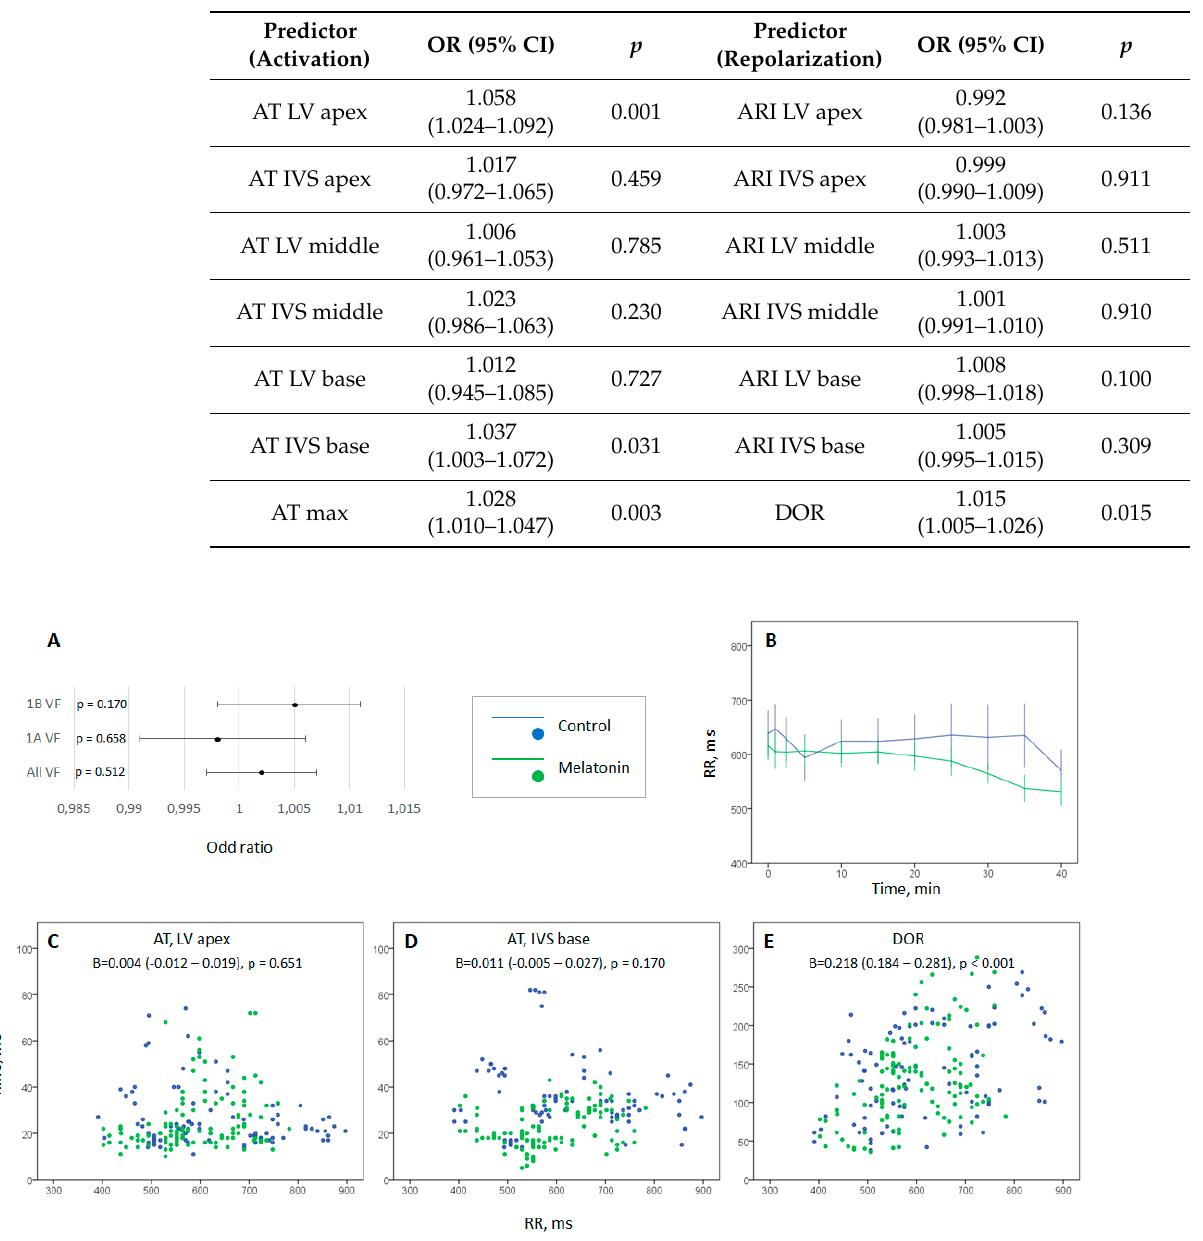
Figure 4. Heart rate dynamics and its contribution to arrhythmia-related parameters. Panel ( A ) shows odd ratio values with 95% CI and p values for association between RR duration and VT/VF occurrence. It demonstrates that VT/VF development was not predicted by heart rate changes. Panel ( B ) displays changes of heart rate (expressed as RR-interval duration, mean±SEM) during coronary occlusion. No statistically significant differences were found neither between the control and melatonin groups, nor between baseline and any time-points during ischemia. Panels ( C – E ) display scatter plots for RR duration and major arrhythmia-associated myocardial electrophysiological parameters throughout all time-points: activation times in the ischemic zone (AT in the LV apex, panel C ), activation times in the border zone (AT in the IVS base, panel D ), and dispersion of repolarization (DOR, panel E ). Regression coefficient with 95% CI and p values are pasted into the plots. See that RR duration was significantly associated with dispersion of repolarization (panel E ), but not activation times (panels C and D ); however, melatonin-treated animals demonstrate shorter ATs in the border zone irrespective of RR duration (panel D ).